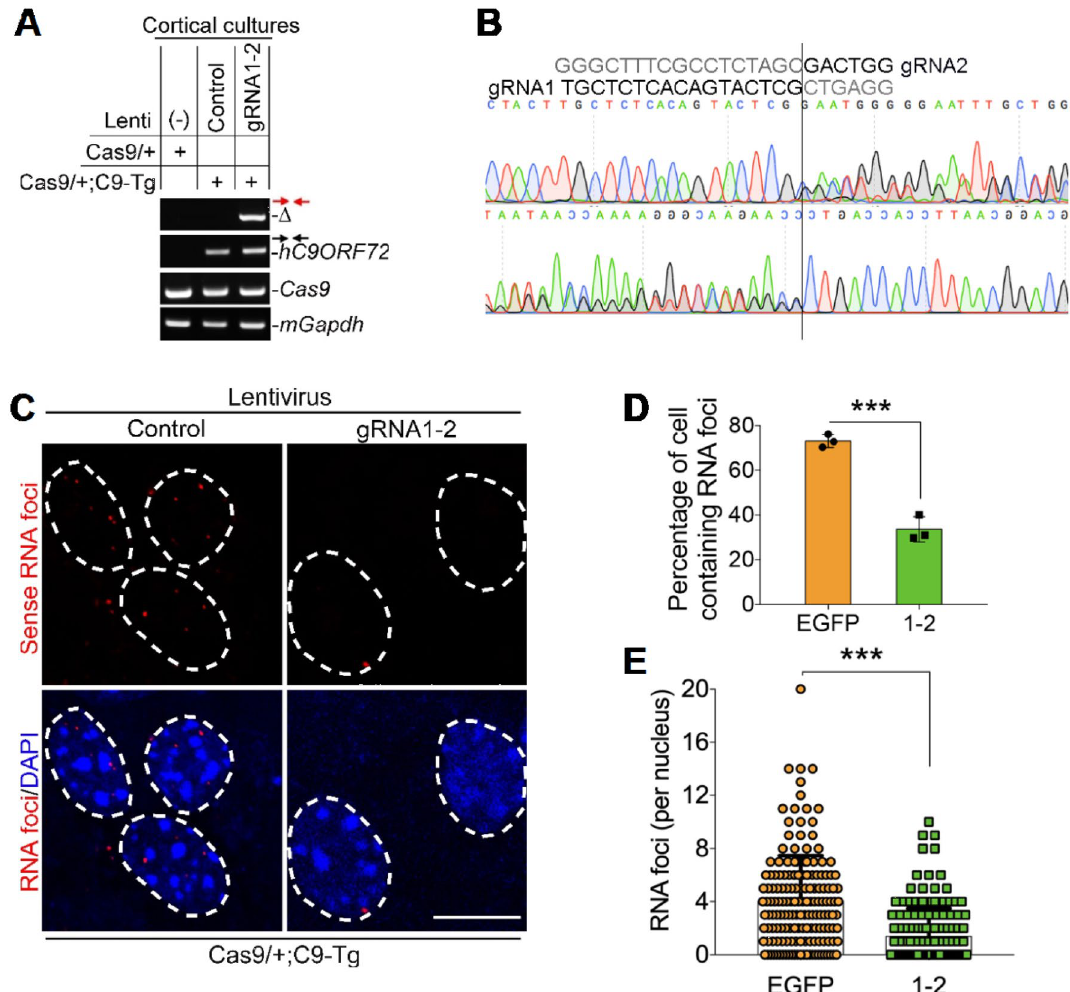
Figure 5. Our designed gRNA1-2 remove C9ORF72 repeat expansion and correct C9ORF72 sense RNA foci in primary cortical cultures. ( A ) The primary cortical neurons cultured from Cas9/ + or Cas9/ + ; C9-Tg mice were infected with control or gRNA1-2 lentiviral particles (Supplementary Fig. 2). The Cas9/ + mouse constitutively expresses Cas9 (PMID: 25,263,330) and the C9ORF72 -BAC transgenic mouse (C9-Tg) carries expanded GGG GCC repeats from patient (C9-Tg mouse line 112, PMID: 26,637,796). The editing site fusions (Δ) were detected by primers shown in Fig. 1A and the PCR conditions (low amount of high GC buffer) were shown in Fig. 1D. The amplicons of C9ORF72 last exon only appeared in the neurons derived from mouse carrying C9-Tg (primers shown in Fig. 1A). Mouse Gapdh served as PCR reaction control. ( B ) The deletion band (Δ) shown in ( A ) was applied for both forward and reverse Sanger sequencing. The editing site fusions took place upstream of the PAM sites. ( C - E ) gRNA1-2 significantly reduced the sense RNA foci produced by the C9ORF72 repeats in the primary cortical cultures derived from Cas9/ + ; C9-Tg mice. Control, control lentiviral particles. Both the percentage of cells containing foci ( D ) and the number of foci per nucleus ( E ) were significantly reduced in the dual-gRNA treatment groups. In ( C) , the dotted line circled nuclei of cultured neurons infected with indicated lentiviral particles. In ( D and E) , the RNA foci counts from three biological replicates. In ( D) , the values are presented as mean ± SEM ( n = 3). In ( E) , we employed “superplot” 70 to transparently show the spread in the number of foci per nucleus, and the values are presented as mean ± SD. *** p < 0.001 (t-test, SPSS). In ( C) , scale bar, 10